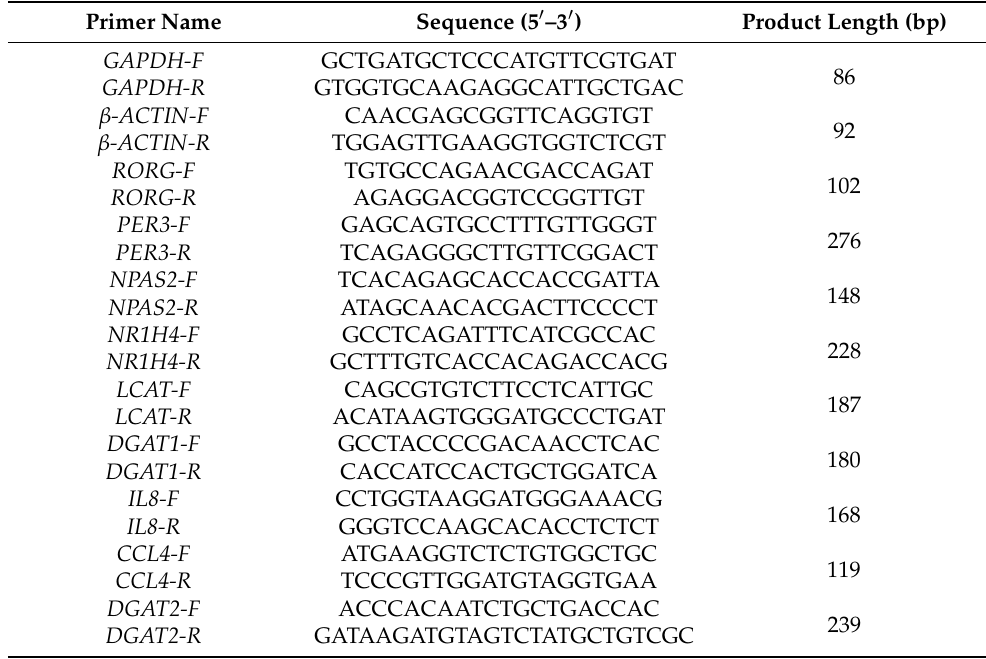
Table 1. Primers used for qRT-PCR in this